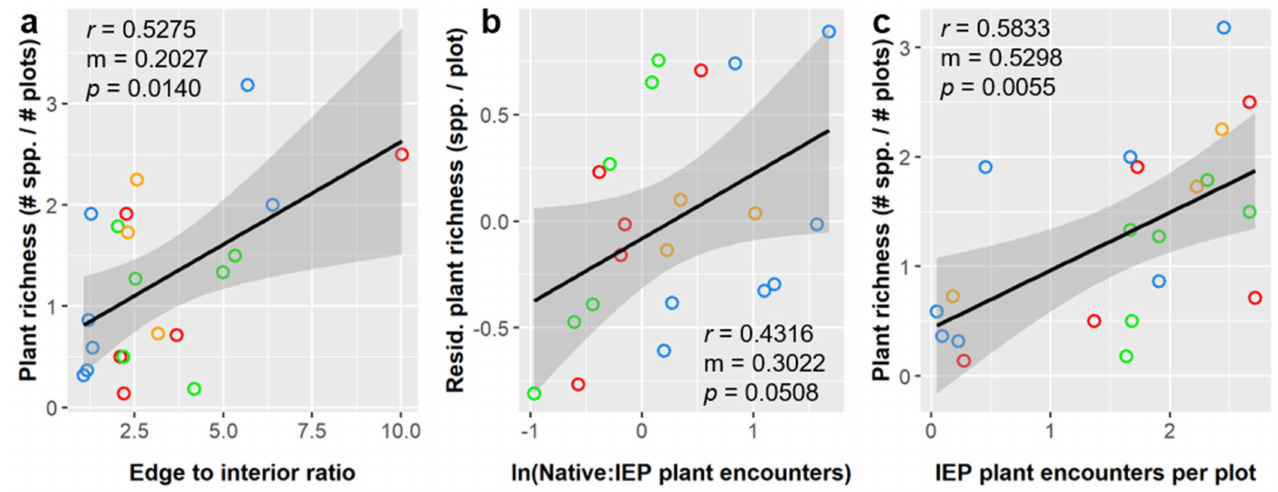
Figure 5. Linear relationships between ( a ) plant richness and edge to interior ratio, ( b ) residual plant richness and the natural log of the ratio of native to IEP plant encounter rates, and ( c ) plant richness and IEP plant encounter rate. Open circles denote values from one study site and are colored to denote habitat class as follows: red, S TX Disturbed Grassland; orange, Tamaulipan Lomas; green, Tamaulipan Shrubland; blue, Texas Coastal Prairies. Legend: r , Pearson correlation coefficient; m, slope from the regression model (effect size); p , p -value from the regression model (see Table S5 for p -values from the ANCOVA model).